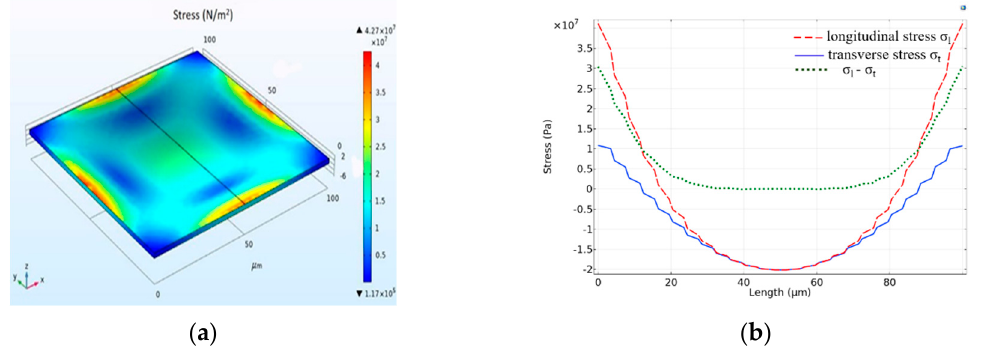
Figure 2. Stress distribution under finite element analysis. ( a ) Stress distribution at 60 kPa; ( b ) longitudinal and transverse stress distribution.